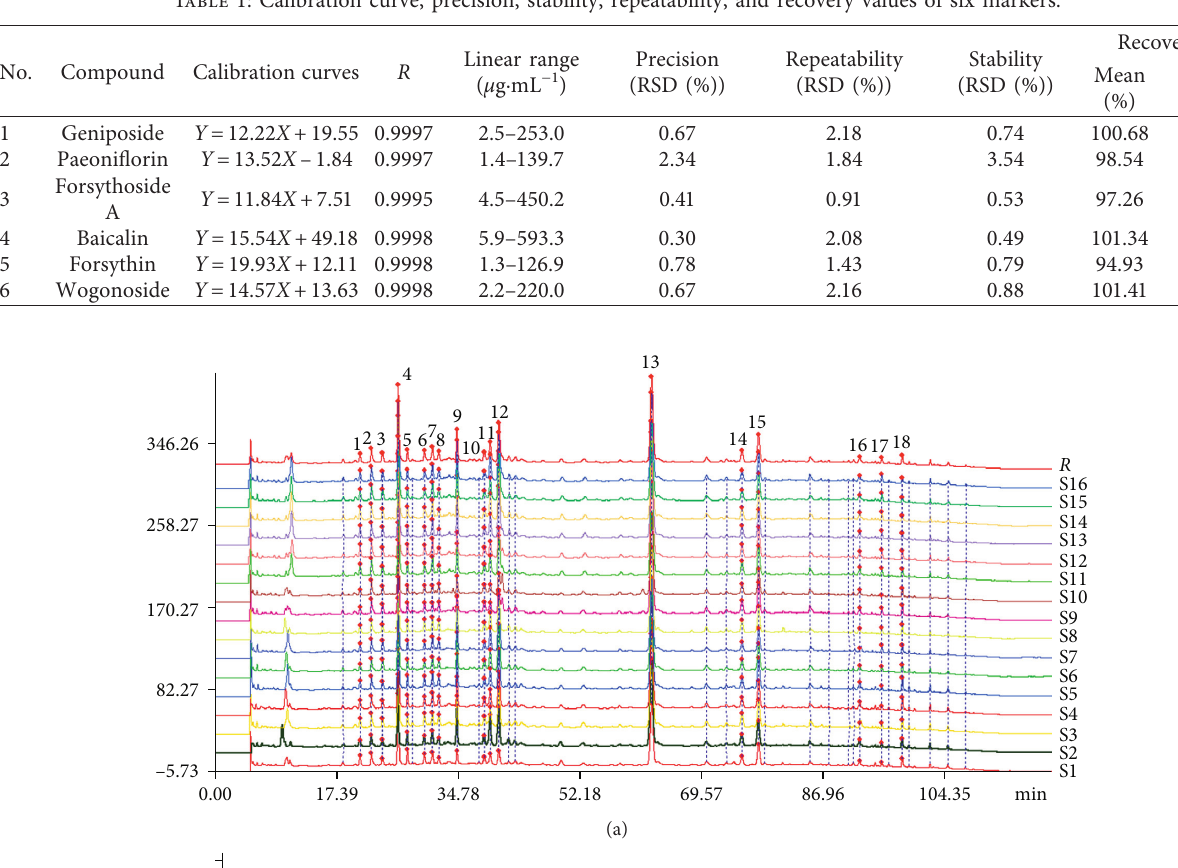
Table 1: Calibration curve, precision, stability, repeatability, and recovery values of six markers.